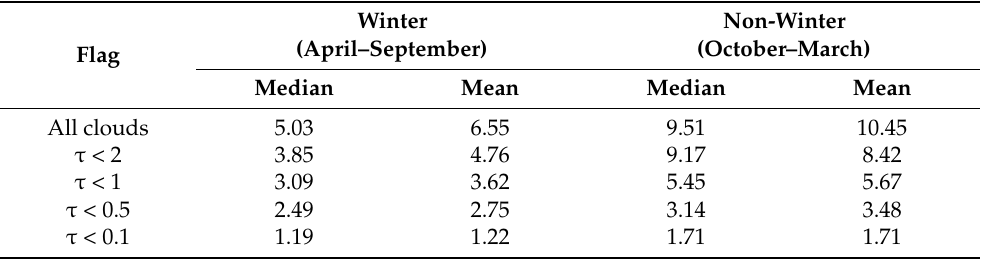
Table 9. Look-up table based on polar regions of GLAS data [19]. Values are expressed in cm.